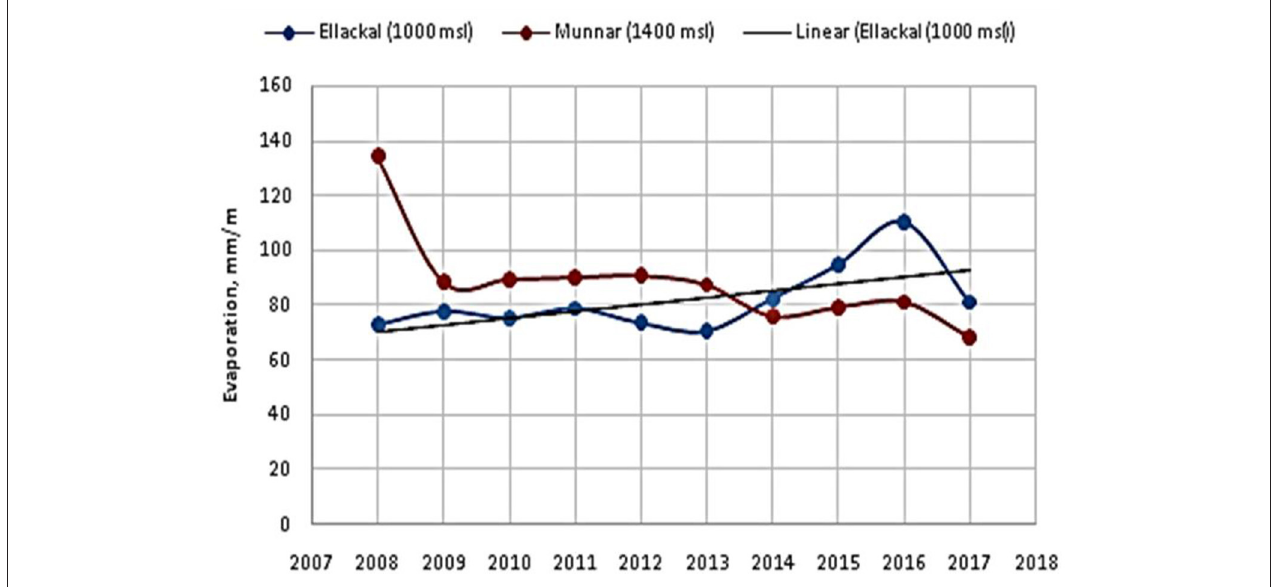
FIGURE 9 | Altitudinal change on the mean monthly evaporation levels in two cardamom growing sites.